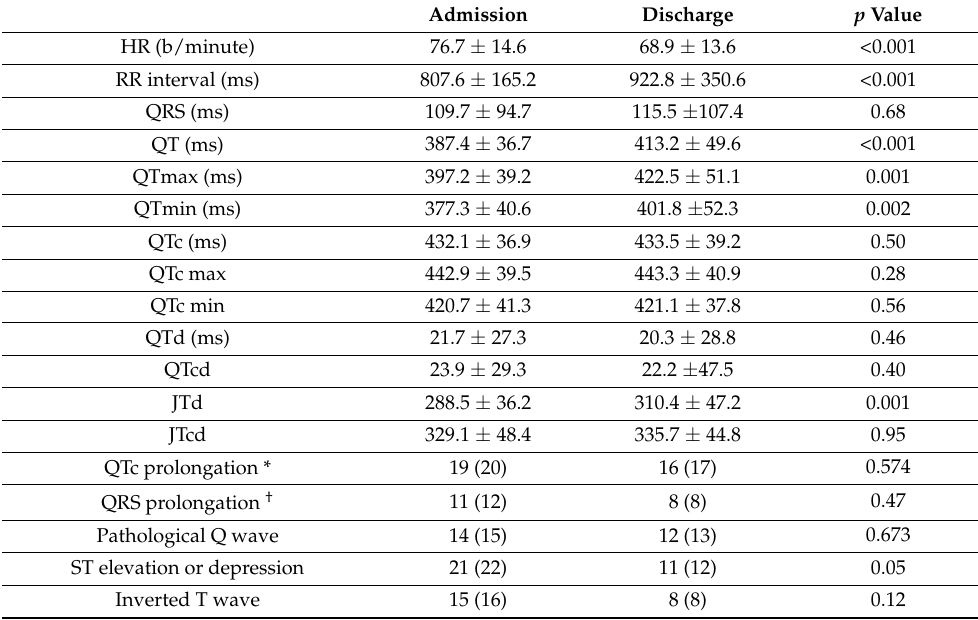
Table 3. Comparison of electrocardiographic findings ad admission and at discharge in the 95 patients that recovered from SARS-CoV-2